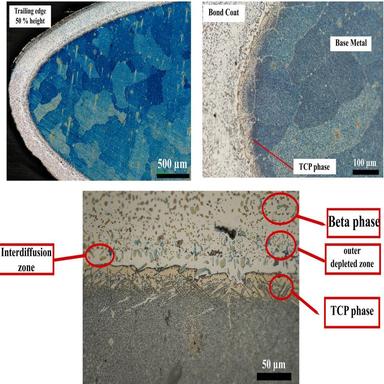
Coating structure after long term operation in the TE zone.